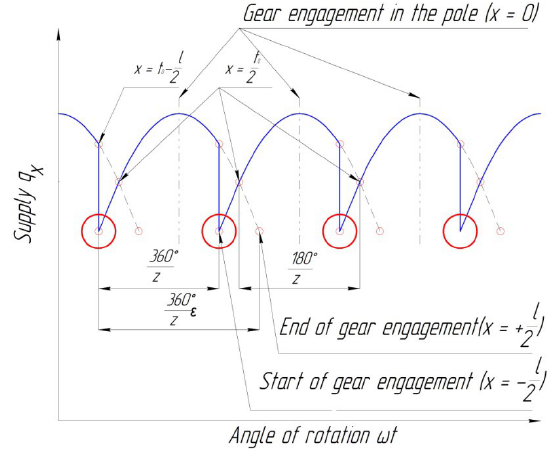
Figure 1. Flow pulsation. Data from the book [2].